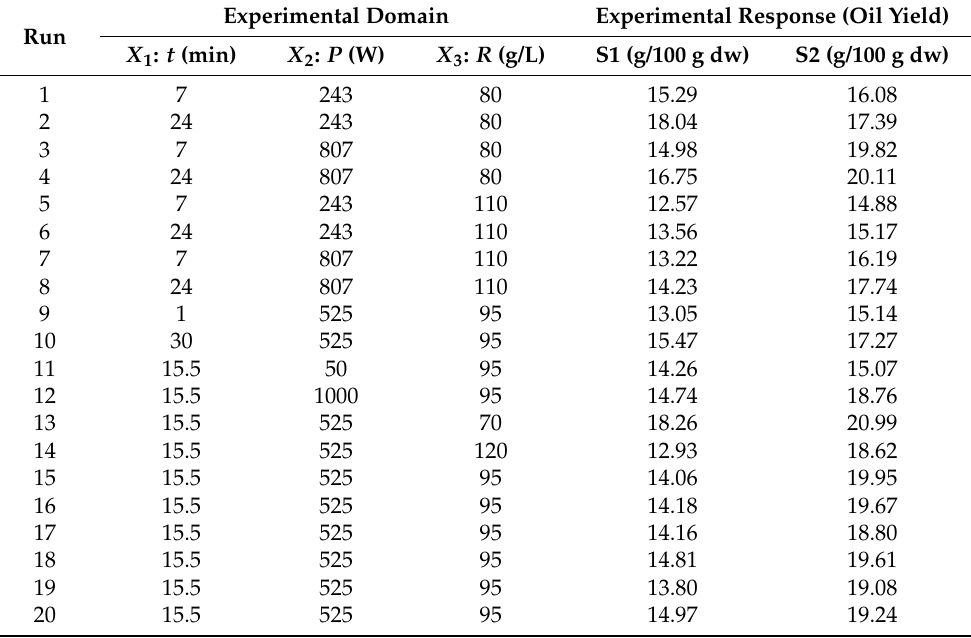
Table 2. Oil content obtained under the MAE conditions defined by the experimental design. Experimental Run